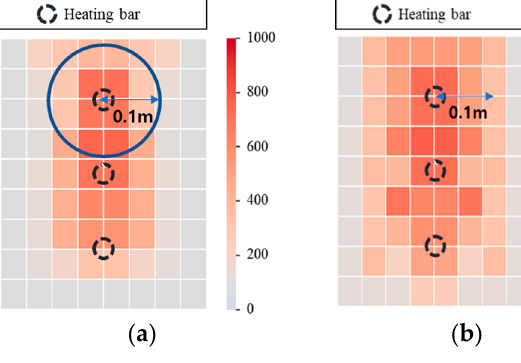
Figure 6. Heat map (side view) after: ( a ) 6 h; ( b ) 12 h; ( c ) 24 h; ( d ) 48 h.